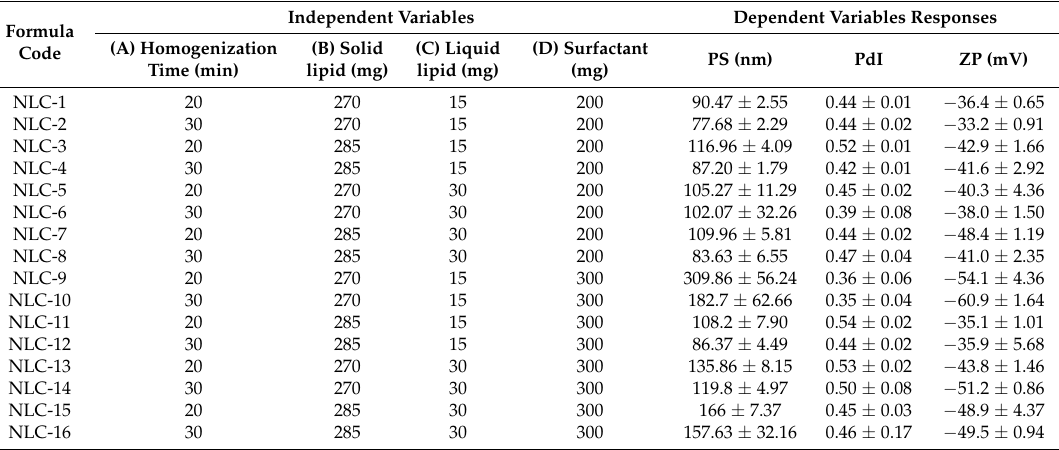
Table 2. Optimization of independent variables and the responses of dependent